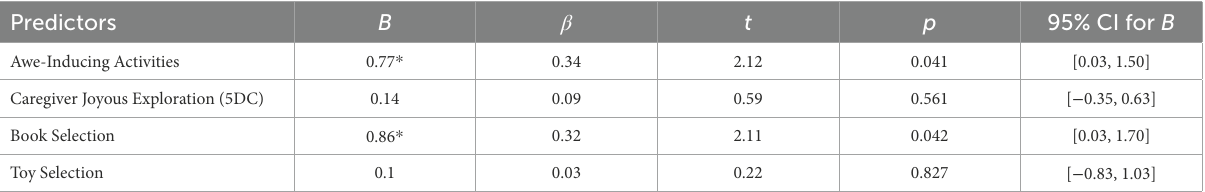
TABLE 8 Follow-up multiple regression analysis summary of Caregiver Activity Subscale model.